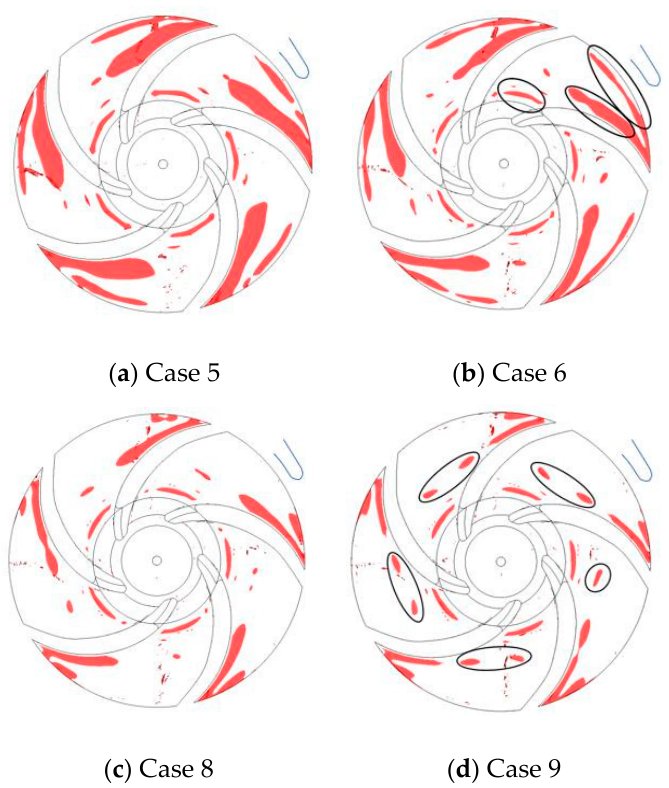
Figure 14. Distribution of the energy gradient function K in the decreasing flow rate section ( K max = 30).